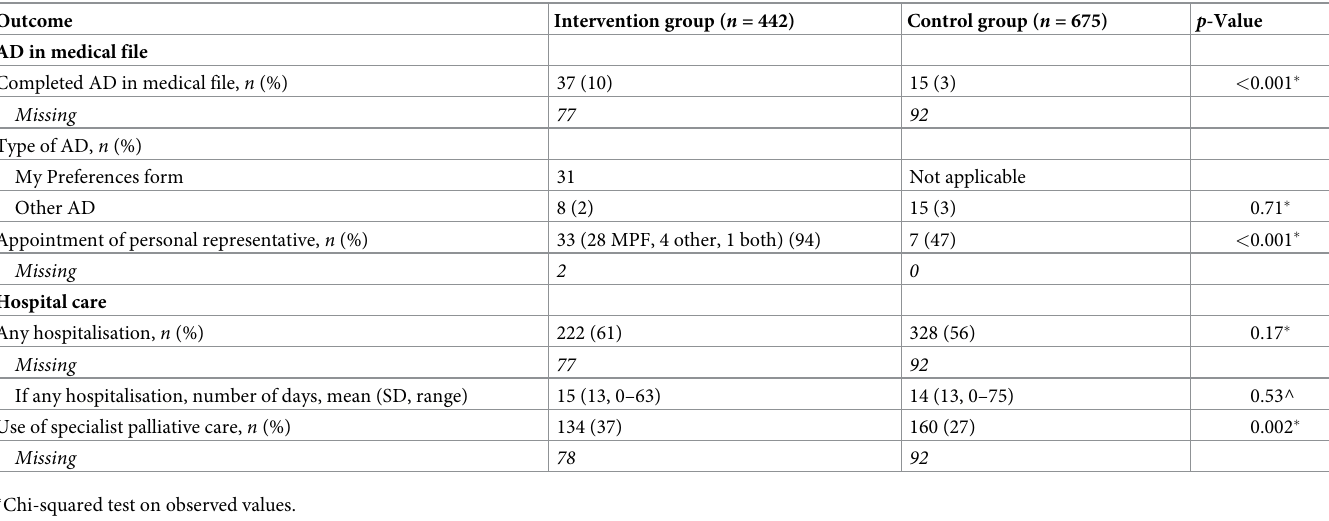
Table 3. The documentation of preferences in medical files and the use of hospital